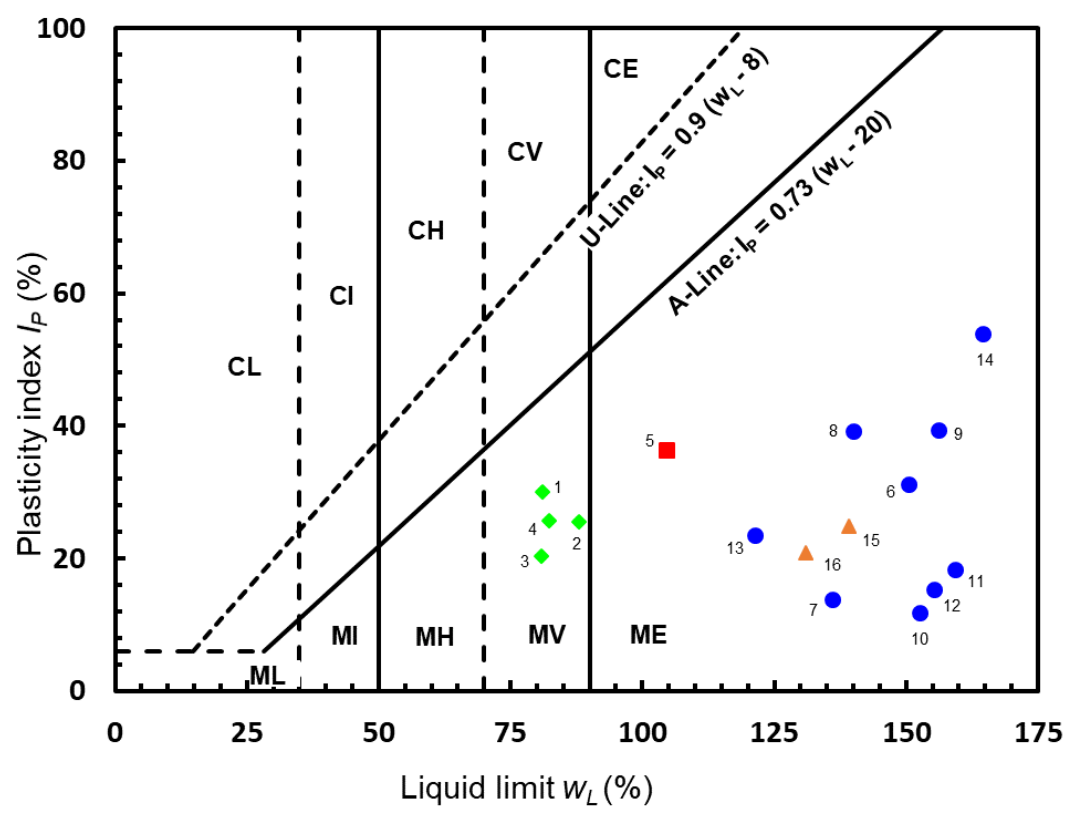
Figure 2: Tested samples shown on Casagrande’s plasticity chart. Note: 1–16, test